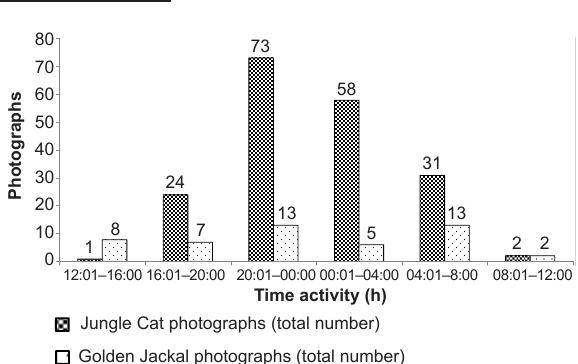
Figure 1. Golden Jackal and Jungle Cat overall temporal activity pattern in Pench Tiger Reserve, as determined from camera trap